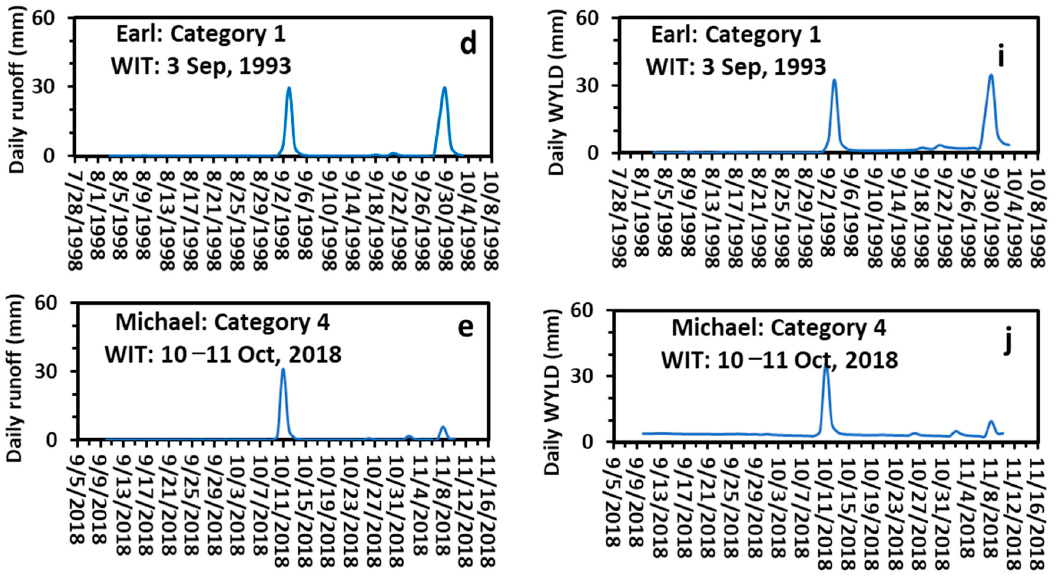
Figure 4. Simulated daily runoff and water yield (WYLD) under five hurricanes from 1966 to 2018. WIT is the watershed impact times.